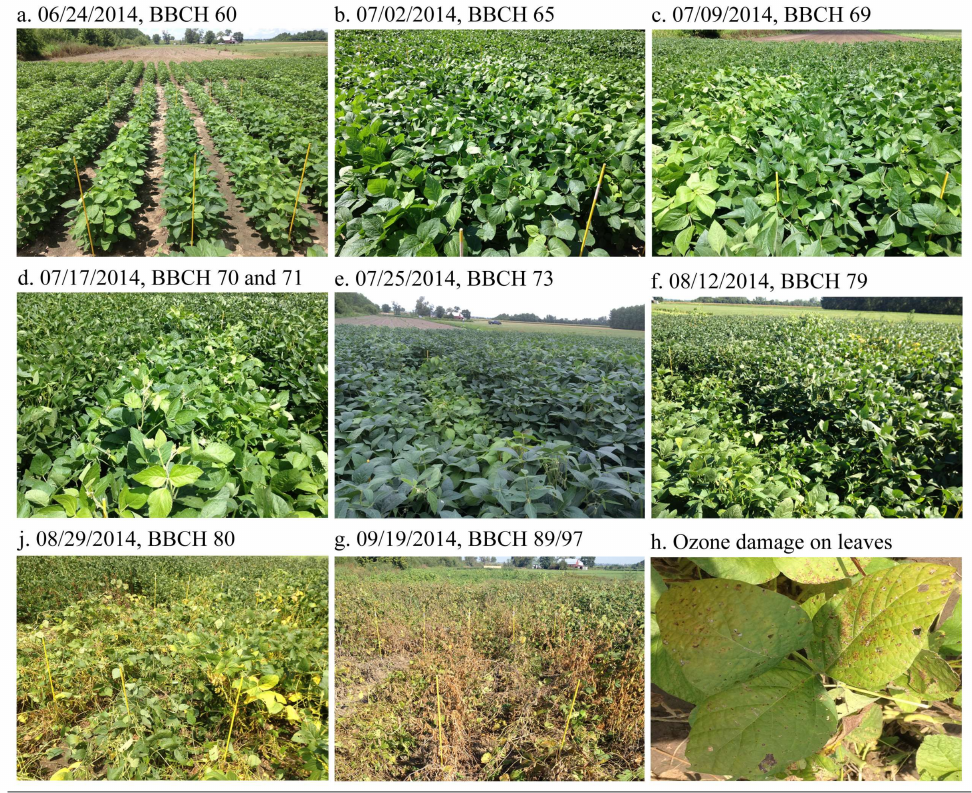
Figure 1. Phenological stages of soybean genotypes during the growth period: ( a – g ) the Biologische Bundesanstalt, Bundessortenamt and Chemical (BBCH) stages [46]; ( h ) leaves showing ozone damage which is becoming visible after BBCH